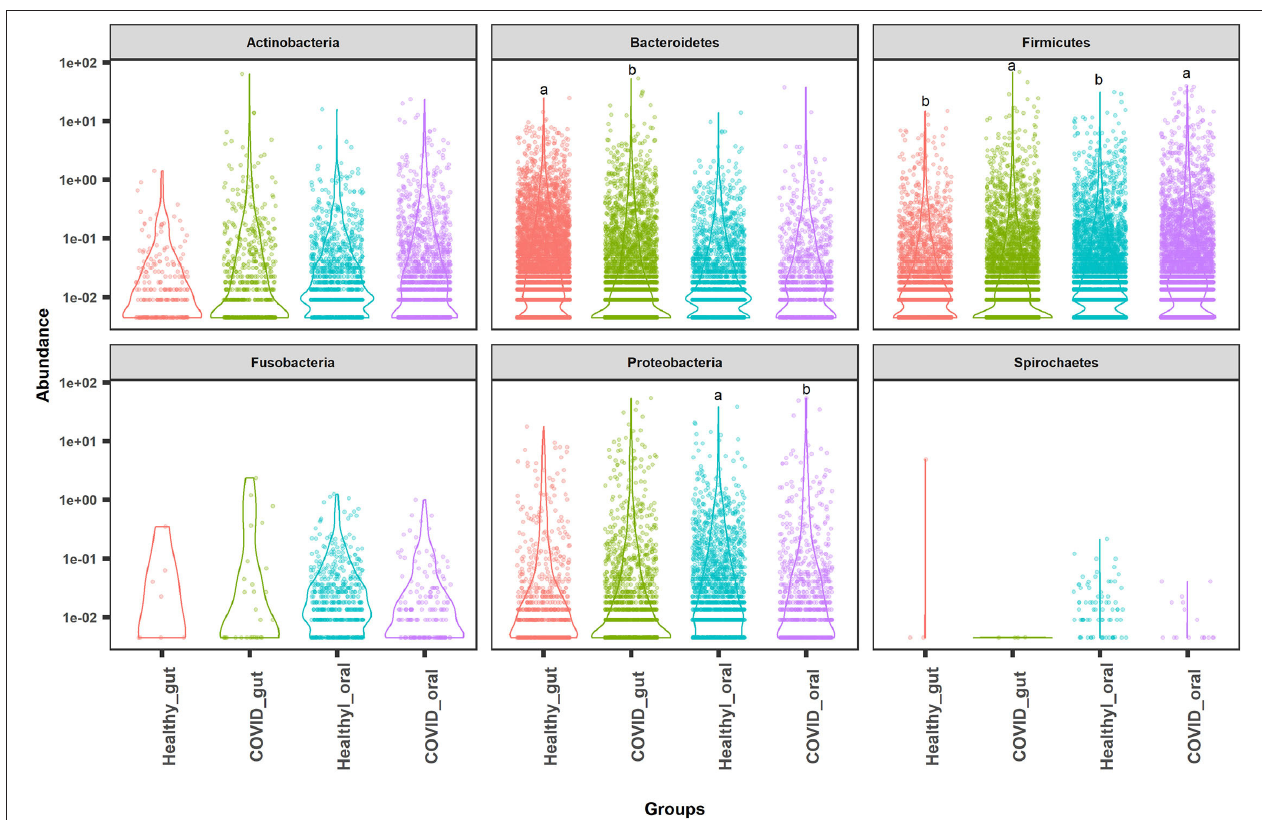
FIGURE 4 | Top abundant bacterial phyla in the gut and oral samples of patients with COVID-19 and healthy controls. Firmicutes , Bacteroidetes , and Proteobacteria were found to be the most predominant phyla across the sample groups. Each sample group is represented by a different color code. Violin dots with different letters (a N , b H ) indicate significantly different read abundance at the phylum level between the gut and oral samples with Mann–Whitney U -test. and D-glutamate metabolism, folate, peptidoglycan, zeatin